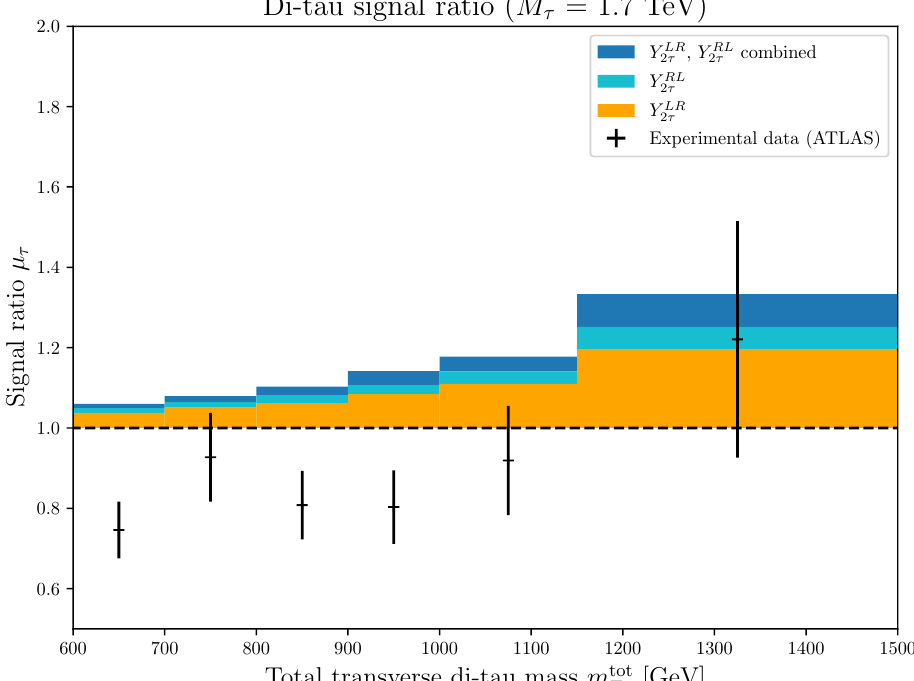
bins studied in the considered ATLAS analysis (for m Figure 11. Signal ratios µ τ for the six m tot T ranging from 600 to 1500 GeV). We show the contributions of a tauquark Φ 1.7 TeV and Yukawa couplings Y LR = 1 . 5 and Y RL = 1 . 5 . We distinguish between the contributions 2 τ 2 τ from Y LR and those from Y RL , taking the two couplings individually, and include as well results 2 τ 2 τ for a setup with both of them